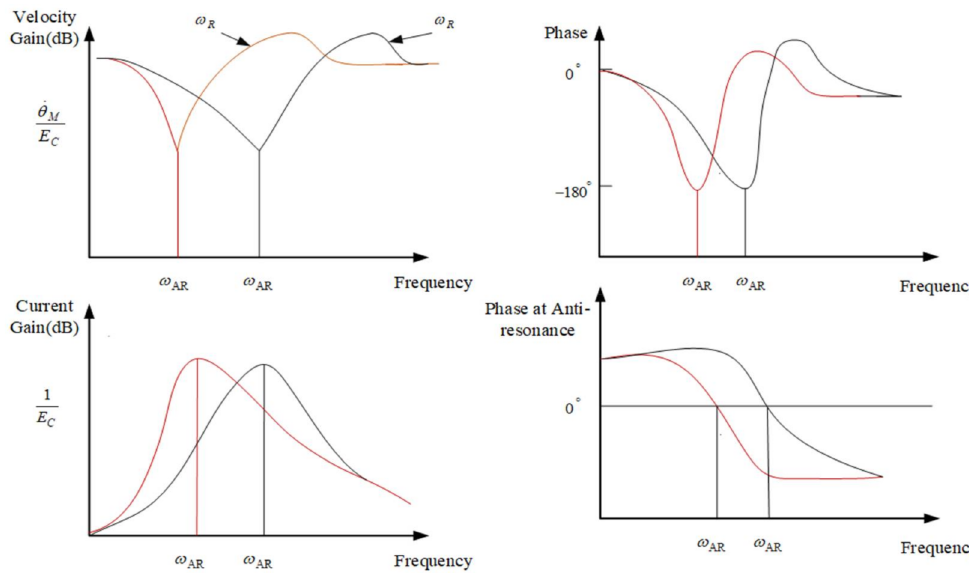
Figure 5. The closed-loop curve diagram of speed and current